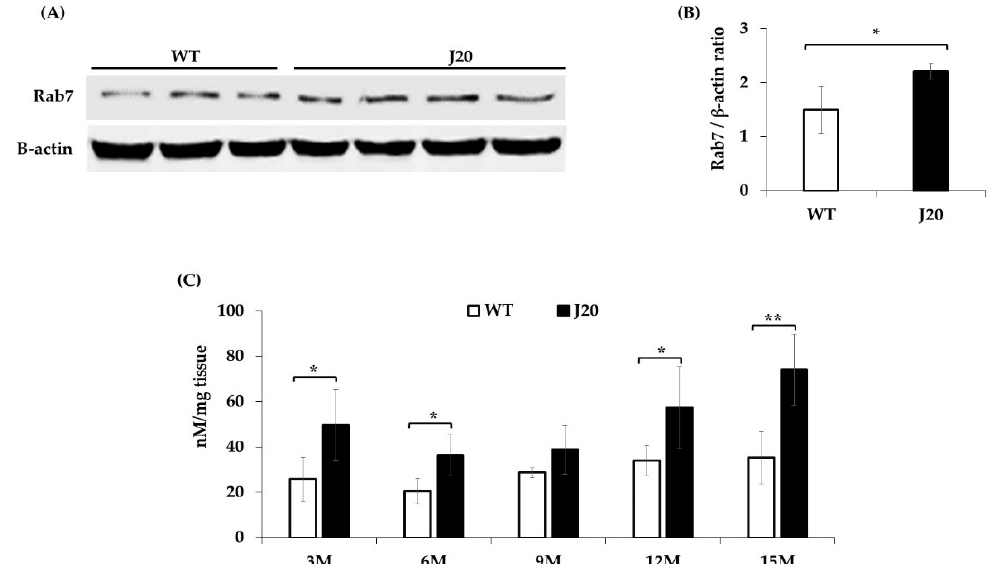
Figure 5. Rab7 expression at 9 months, and time-dependent change of ROS at 3, 6, 9, 12, and 15 months in the hippocampus of WT and J20 mice. Total Rab7 expression levels were analyzed by the Western blotting technique. Representative Western blotting data of J20 ( n = 4) and WT ( n = 3) mice are shown ( A ). Densitometric analysis was performed using ImageJ software, and is shown ( B ). ROS levels were quantified by a DCF-DA probe assay. The analyzed result is shown ( C ). Statistical significance is denoted as follows: * p < 0.05, ** p < 0.01. M indicates months.